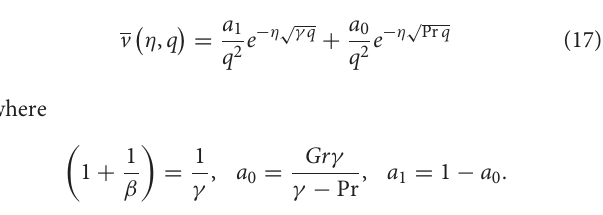
FIGURE 2 | Velocity plot for Gr